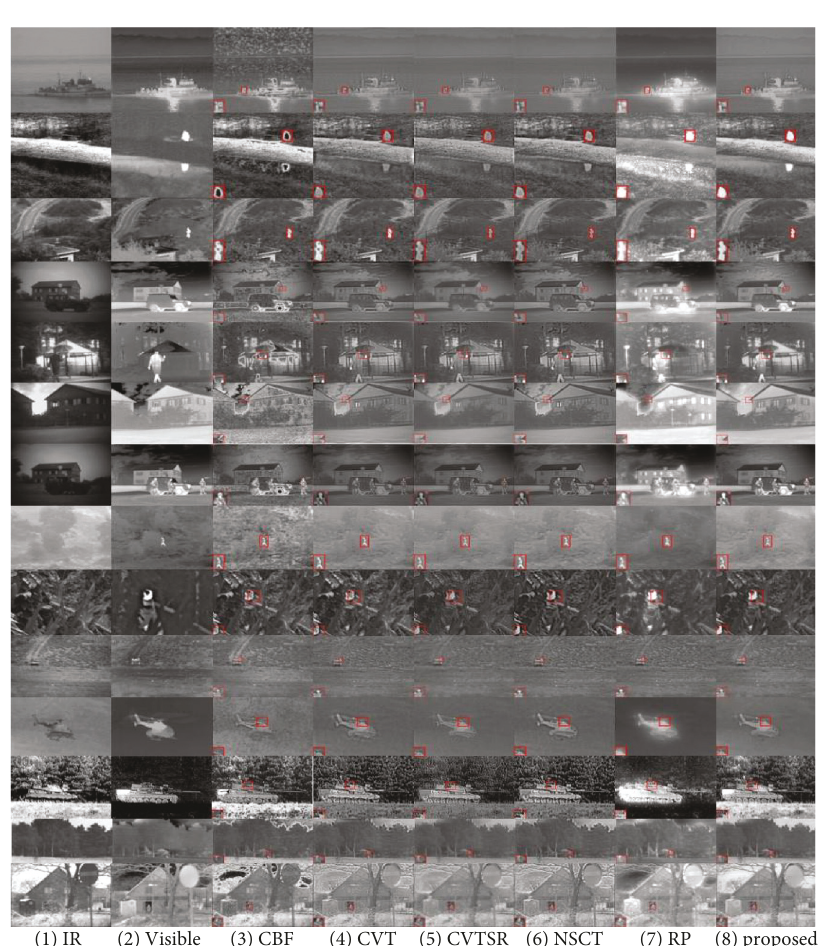
Figure 5: Comparison of the fusion results from different methods on the source